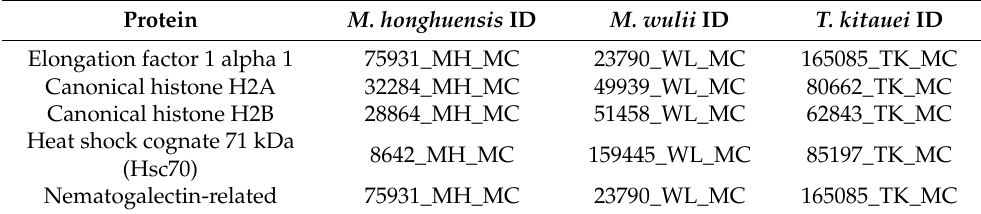
Table 1. Putative nematocyst core set that was conserved through cnidarians.